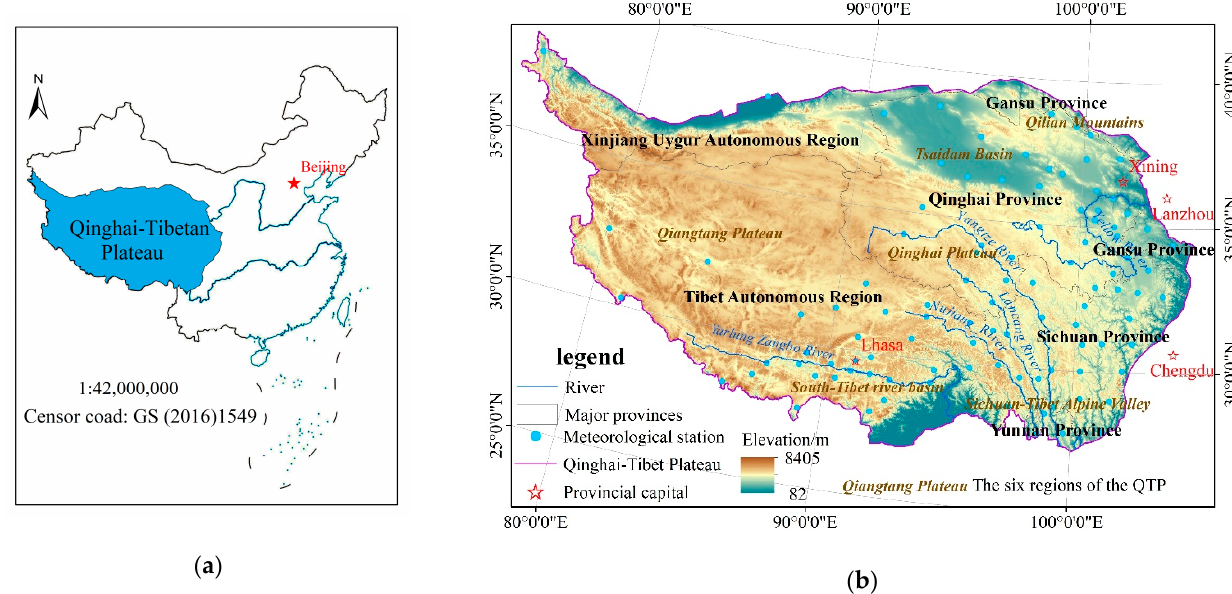
Figure 1. Geographical location of the Qinghai-Tibet Plateau (QTP). ( a ) location of the QTP; ( b ) different regions of the QTP.